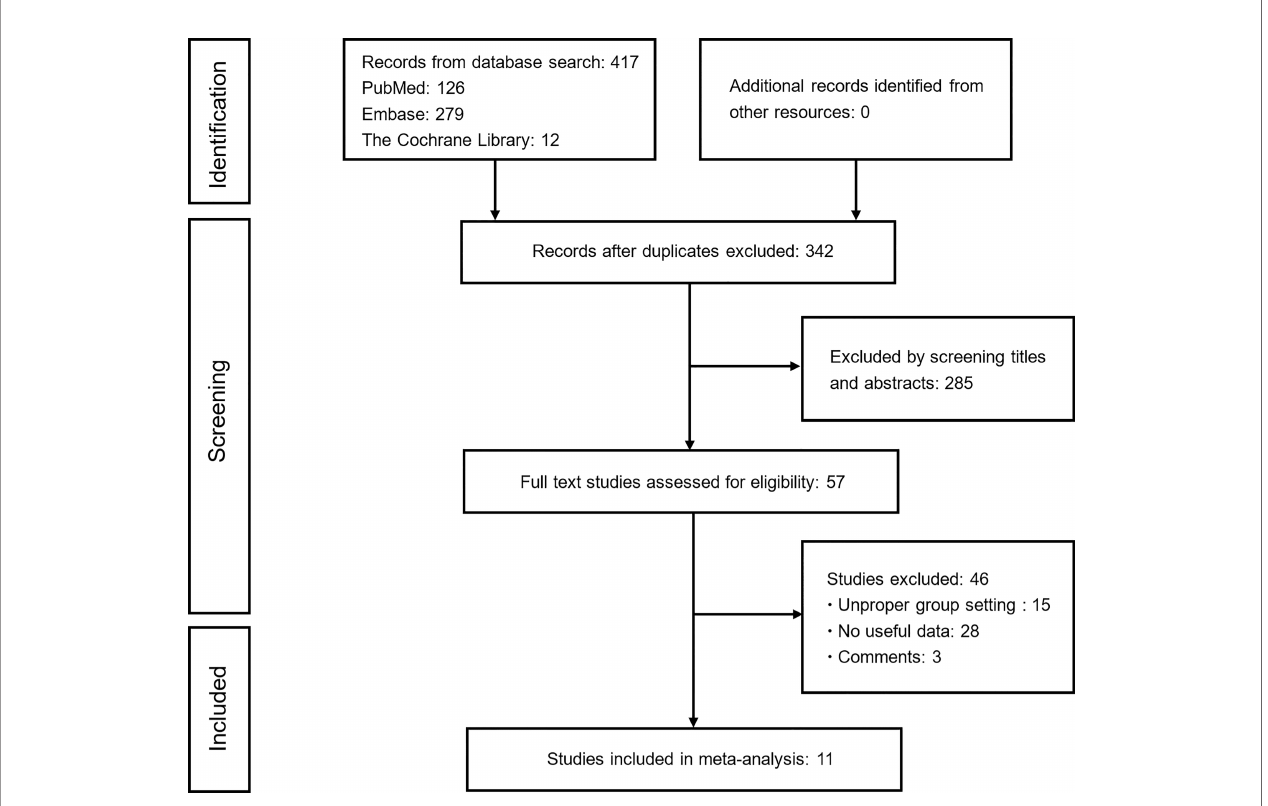
FIGURE 1 | Flowchart of study selection. Based on the inclusion and exclusion criteria, 11 studies were included in this